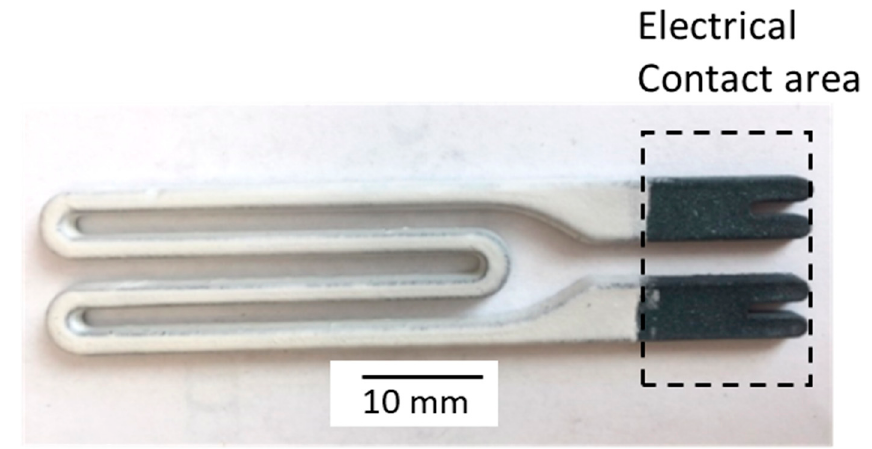
Figure 1. EBC-coated SiC heating element via